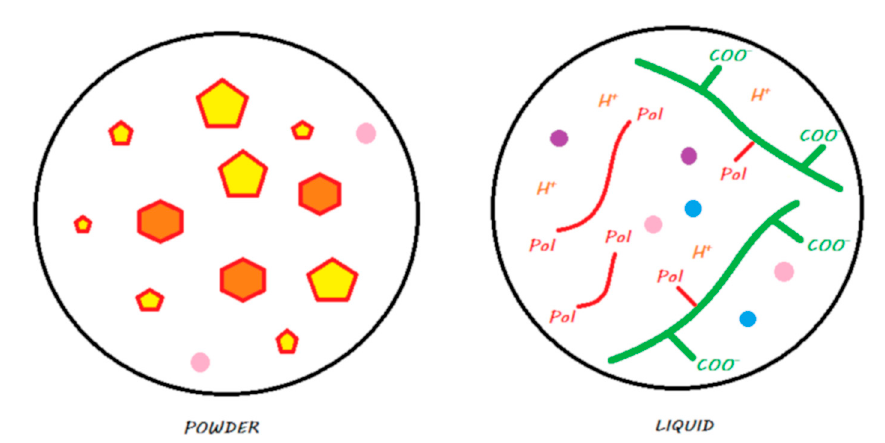
Figure 19. Surefil One in its storage medium. For RM-GICs, the powder contains silanated FAS fillers, some chemopolymerization components, and silanated unreactive fillers. The liquid contains water, an ionized modified polyacrylic acid with photopolymerizable groups, a blend of monomers, camphorquinone as a photoinitiator, and some chemopolymerization components.